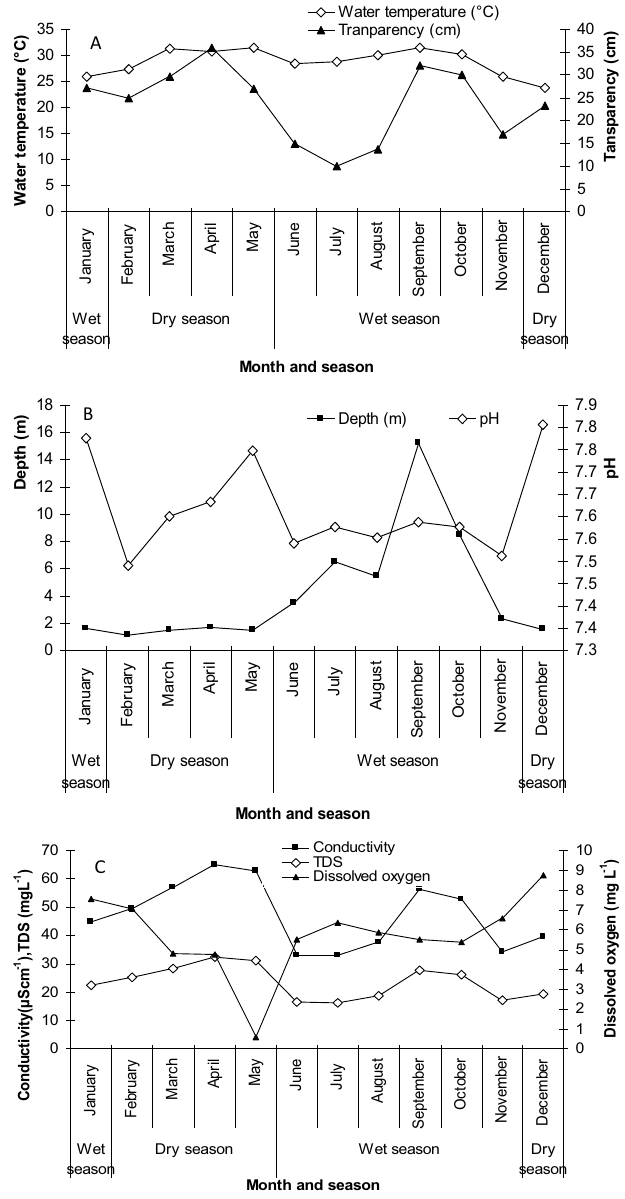
Fig. 5. Monthly variation of environmental variables monitored in the Pendjari River from January to December 2009. A: water temperature ( ° C)andtransparency(cm).B:waterdepth(m)and pH. C:conductivity ( m Scm (cid:1) 1 ), TDS (mgL (cid:1) 1 ) and dissolved oxygen (mgL (cid:1) 1 ). June, and attained the maximum value in September during the fl ood season (15.3m). Conductivity (47.1± 11.7 m S cm (cid:1) 1 ) displayed highest values in April (65.0 m S cm (cid:1) 1 ) and then declined to the lowest value (32.8 m S cm (cid:1) 1 ) in July during the rainy season. Total dissolved solids (TDS) showed a similar pattern of fl uctuation with conductivity; with the lowest value of 16.2 mg L (cid:1) 1 in July and the highest value (32.3 mg L (cid:1) 1 ) in April (23.4 ± 5.8mg L (cid:1) 1 ). Dissolved oxygen varied from 0.6 mg L (cid:1) 1 in May to 8.6 mg L (cid:1) 1 in December (5.7 ± 2.0mg L (cid:1) 1 ) (Fig. 5C). This indicates anoxic conditions in May and is probably associated with juvenile mortality. Page 5 of